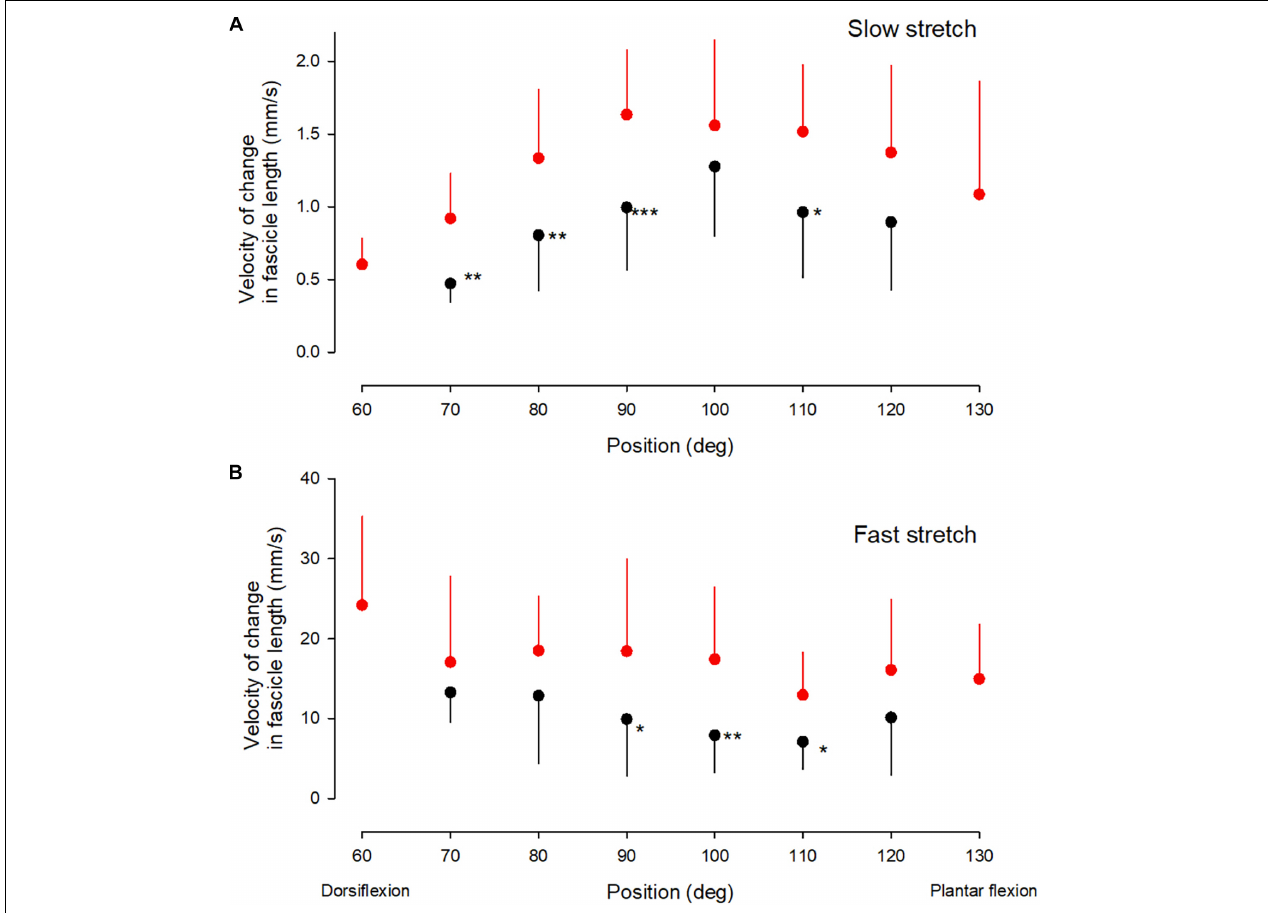
FIGURE 4 | Velocity measurements. Medial gastrocnemius fascicle velocity at different ankle joint positions throughout the range of movement during slow stretch (A) and fast stretch (B) . Mean, error bar 1 SD. CP, black corcles and NI, red circles. Statistically significant differences in measurements between the two groups are indicated by stars. * p < 0.05, ** p < 0.01, *** p <